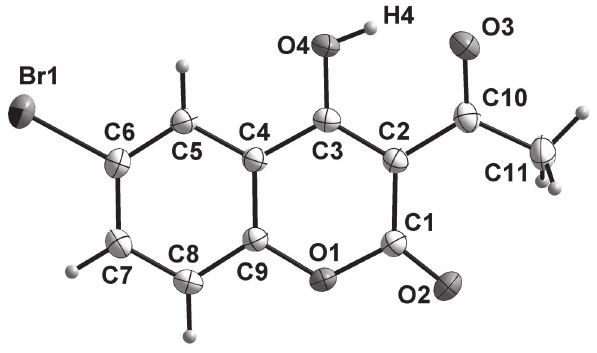
Table 1: Data collection and handling.